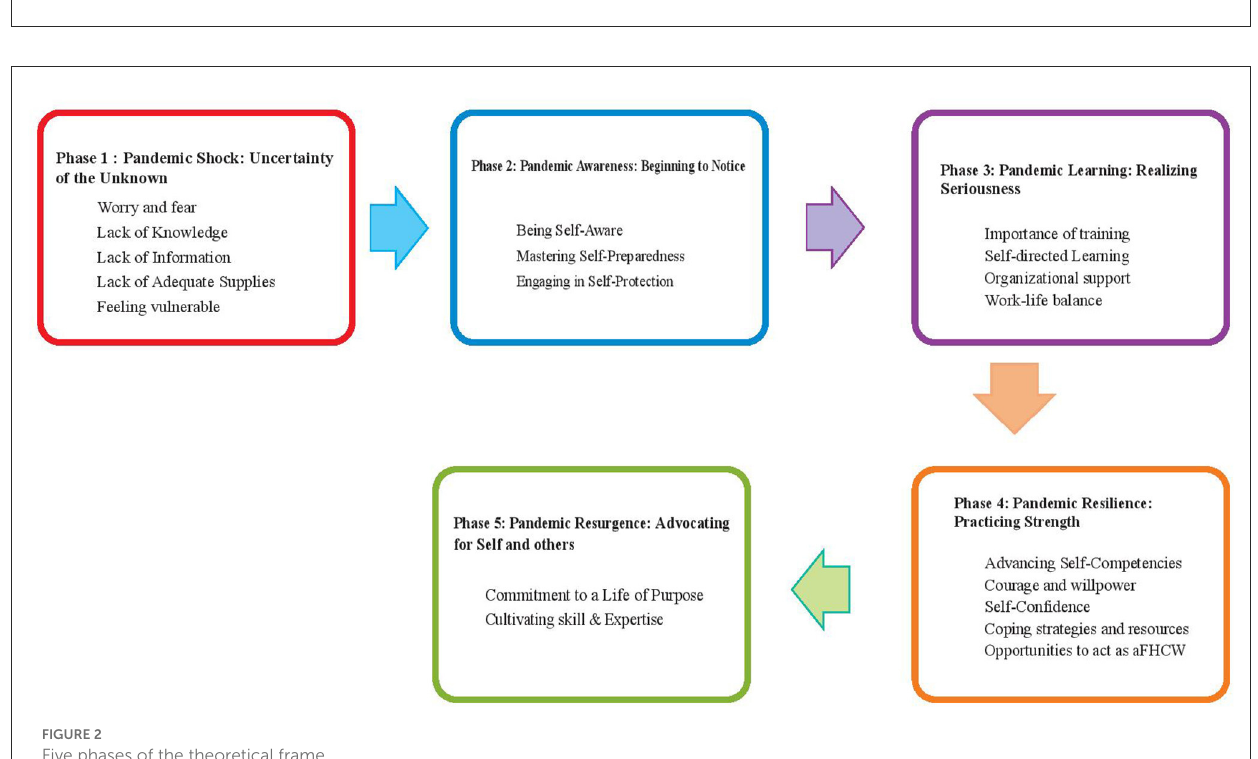
FIGURE2 Five phases of the theoretical